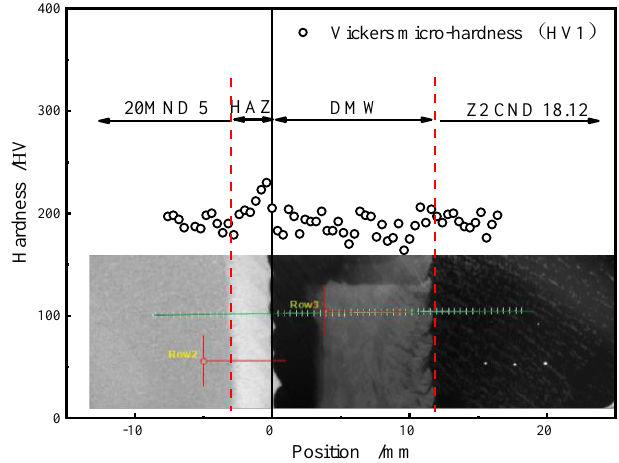
Figure 10. The results of Vickers micro-hardness test of a DMW joint.